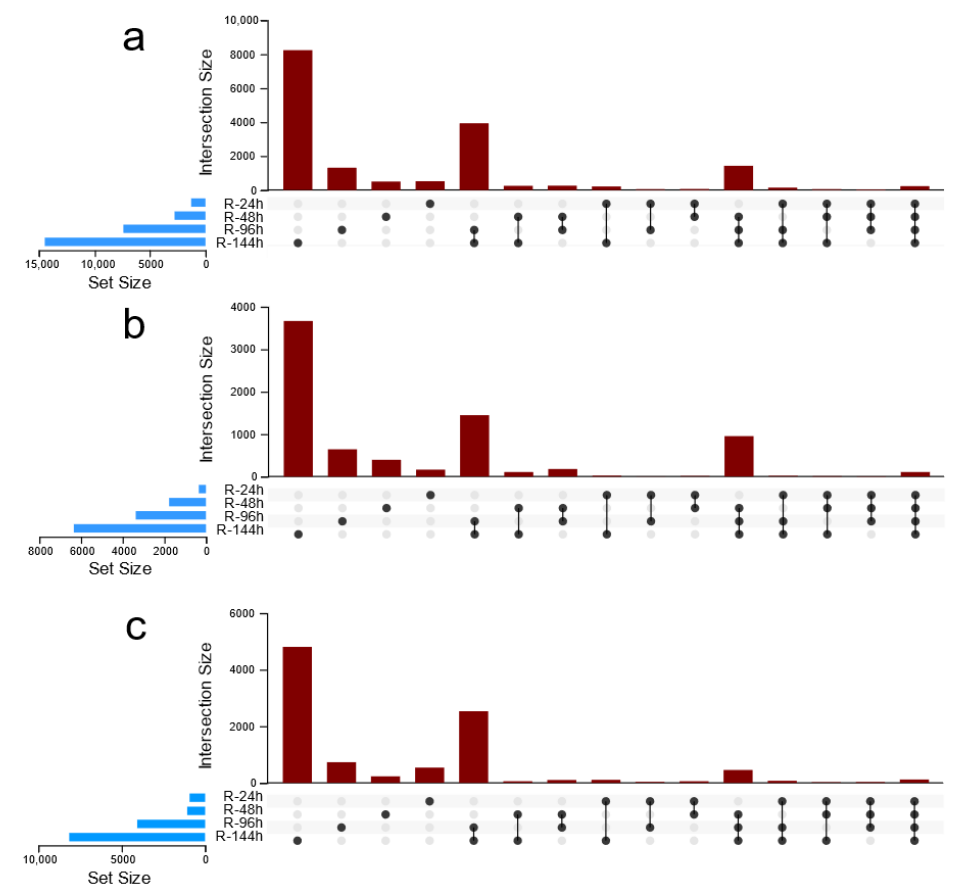
Figure 2. Venn diagram of differentially expressed genes at each point. ( a ) All DEGs; ( b ) Upregulated DEGs; ( c ) Downregulated DEGs; R: root. DEGs, differentially expressed genes.